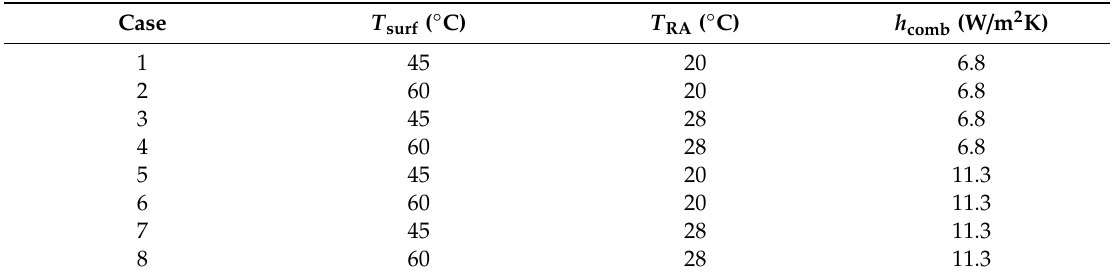
Table 4. Experiment cases for developing the empirical model of the TERP in heating